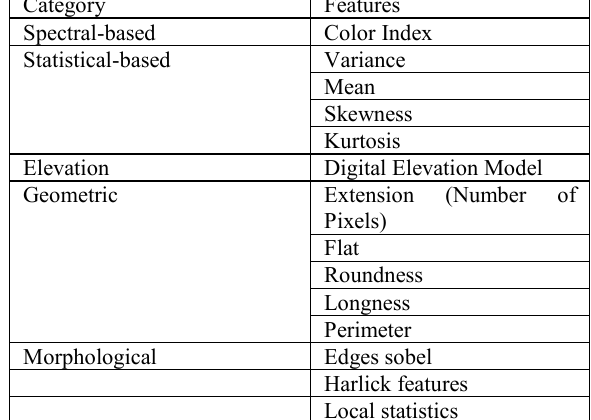
Table 2. Features selected for the classification input dataset in object-based approach, computed using ORFEO